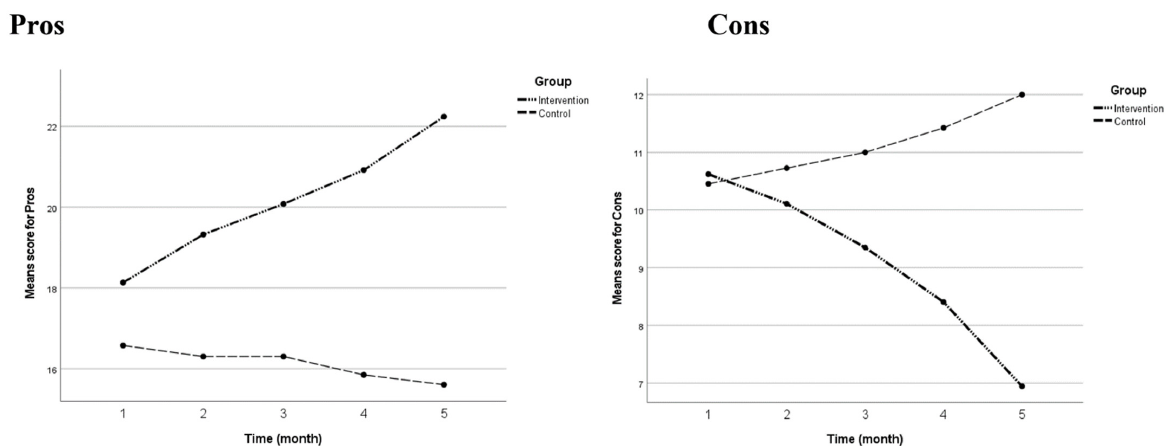
Figure 2. Mean score changes for Pros and Cons of DB-M from pre-intervention to post-intervention. Note the plot shows the mean score of Pros and Cons of DB-M scores (y-axis) for pre-intervention (time 1), 1st month (time 2), 2nd month (time 3), 3rd month (time 4) and post-intervention (time 5; x-axis) for both groups (intervention and control).